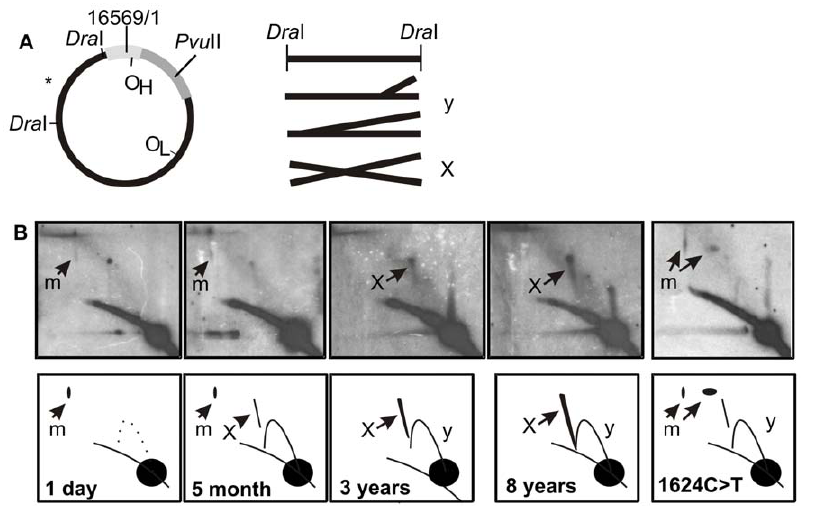
Figure 1. Specific change in human heart mtDNA replication and recombination in early childhood. (A) A diagram of human mtDNA showing the analyzed Dra I ND5 probed fragment (nt 12,271-16,010, probe location denoted with *) and resulting molecular forms of the fragment after digest. Simple, dsDNA replication fork migrate on the Y-arc (y), four-way junctional molecules on the X-arc (X). (B) 2D-AGE of the Dra I ND5 fragment from a one-day old newborn, five-month old, three-years old, eight-years old human heart mtDNA and a one-day old neonate with mitochondrial disease due to a homoplasmic m.1624C . T mutation. Notice the accumulation of X-arc signal and an overall increase in replication intermediates with aging. Degraded slow-moving Y-arc structures (m), indicators of ribonucleotide-incorporating replication, can be seen on some of the samples (see also [5].).